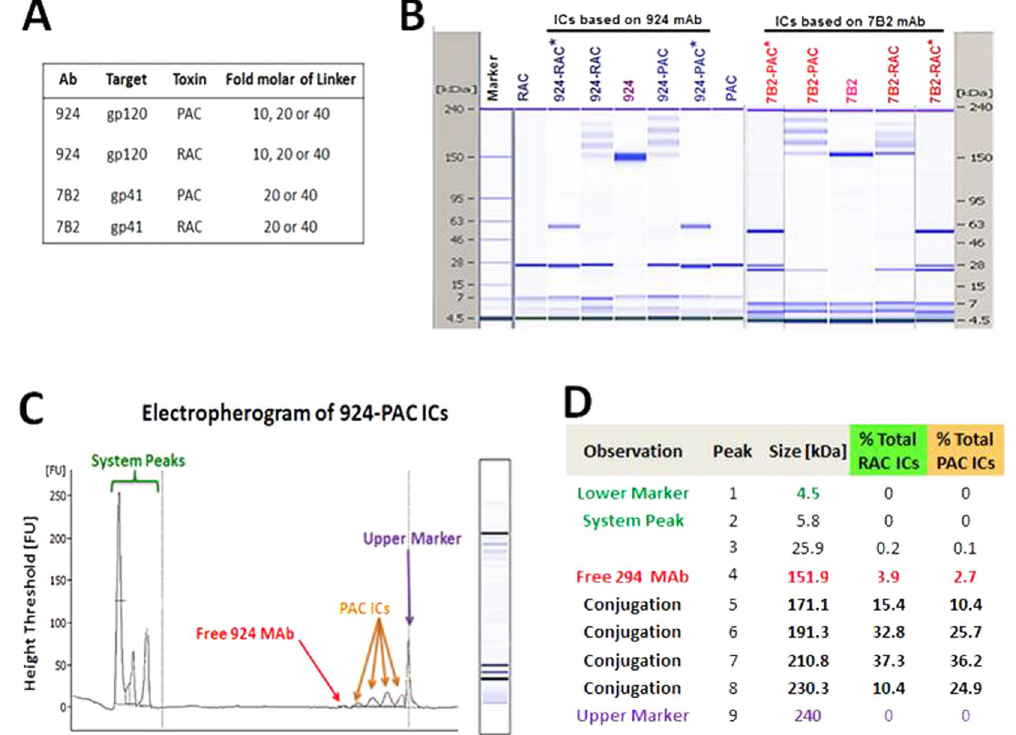
Figure 1. Characterization of immunoconjugates (ICs). ( A ) The table shows components of ICs with different concentrations of LC-SPDP biolinker. The final products include 10 ICs as well as 2 conjugates with irrelevant MAb, as control. ( B ) Microcapillary electrophoresis of reduced and non-reduced ICs. Results are displayed in the familiar format of a coumassie stained gels. Size standards are indicated on the side of each “gel”. PAC, RAC and light chain of 924 MAb represent the same molecular size on the gel. The star symbol ( * ) means under reducing conditions by using 2-Mercaptoethanol. The ICs represent the conjugation with 40-fold molar excess of LC-SPDP biolinker. In Figure S1, microcapillary electrophoresis of conjugates with different concentration of biolinker are demonstrated. ( C ) Electropherogram of 924-PAC IC, after passing from Ultra-100K centrifugal filter, demonstrates the negligible presence of free MAb as well as MAbs conjugated with 1, 2, 3 or even 4 PAC. ( D ) Peak table of RAC and PAC ICs show the percentage of MAbs conjugated with A